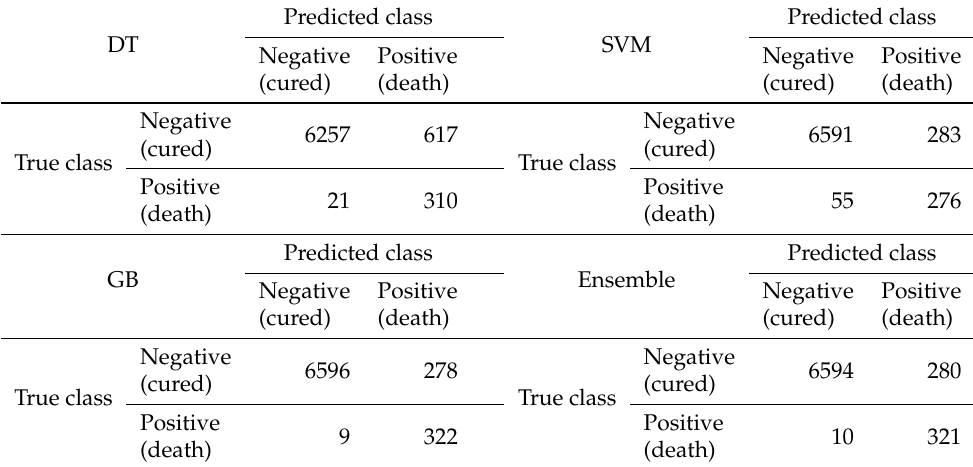
Table 8. Confusion matrix of Decision Trees (DT), Support Vector Machine (SVM), Gradient Boosting (GB) and ensemble models using the balanced data